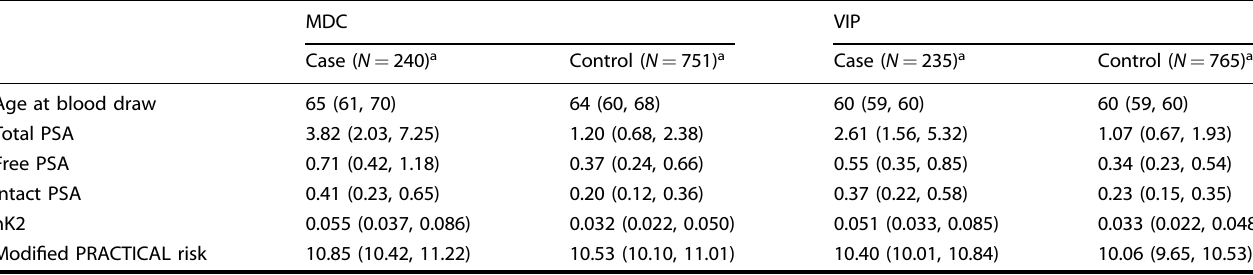
Table 1. Patient characteristics a at baseline by case status b in patients with available polygenic risk scores in the MDC and VIP case-control